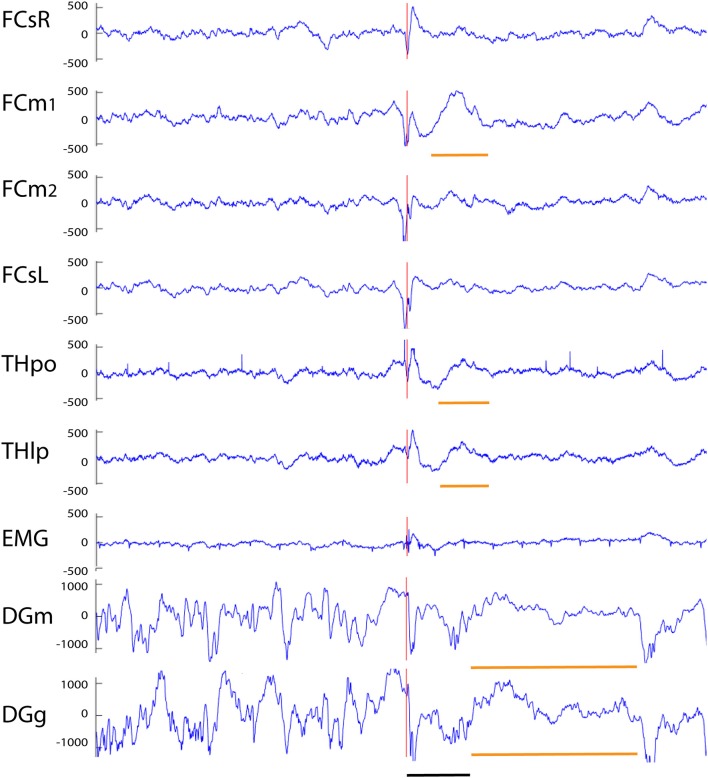
Example of a cortico-hippocampal spike with after hyperpolarization recorded from an APP/PS1 mouse. A spike on FCsL and both FCm channels is followed by a spike on FCsR reference channel 2 ms later (red vertical line). About 10 ms later a spike can be seen on both hippocampal channels (which shows up as a surface-positive deflection in all other channels). This is followed by a slow surface-positive wave lasting for ~ 150 ms on medial frontal and thalamic channels (short horizontal orange line) and up to 600 ms on hippocampal channels (long horizontal orange line). Channel abbreviations as above, except DGg, dentage gyrus, stratum granulare. Scale bar = 200 ms.